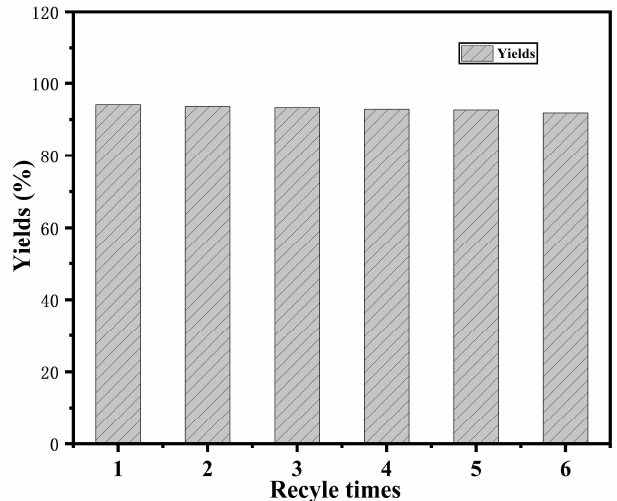
Figure 5. The reusability of Zr(40)-ZSM-5-st(500) for esterification.